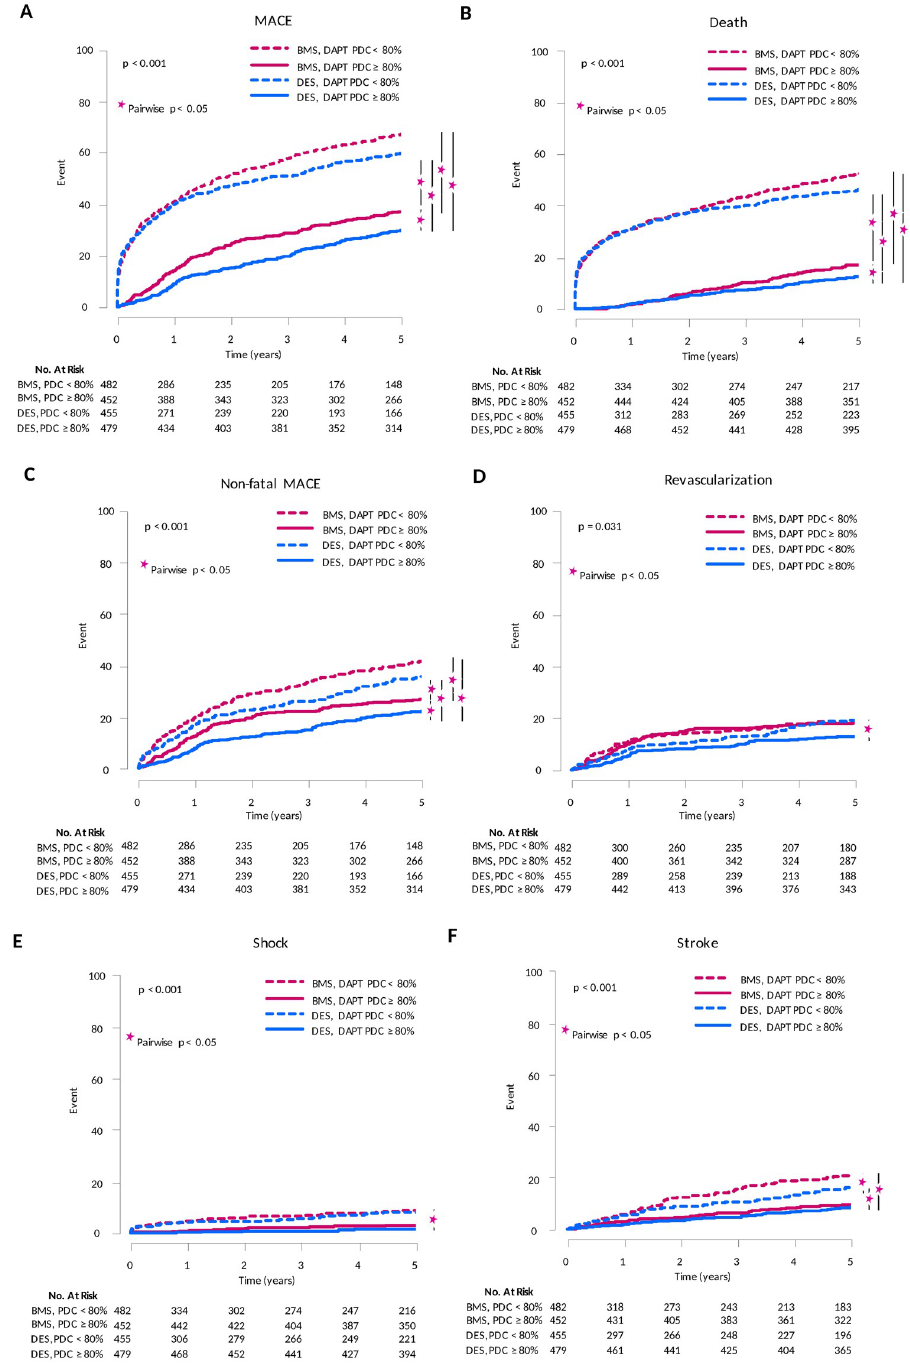
Fig 3. Impact of medication adherence to dual antiplatelet therapy on the propensity score-matched 5-year risk of clinical event. The impact of medication adherence to DAPT on the clinical outcome of propensity score-matched patients was investigate further using PDC � 80% as the threshold of good adherence. Among patients with PDC � 80%, DES showed much lower risk of MACE, all-cause death, and non-fatal MACE. Among patients with PDC < 80%, there was no difference of these risk between DES and BMS. DES with PDC < 80% showed 2-fold higher MACE risk compared to BMS with PDC � 80%.